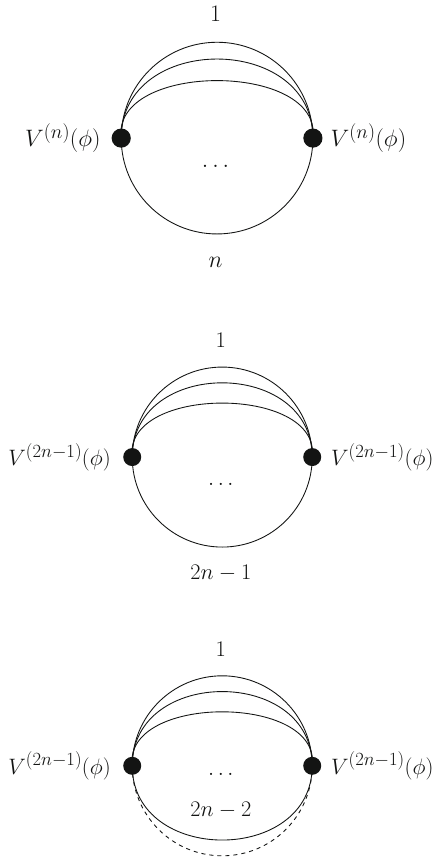
Fig. 1 Diagrammatic representation of (11) in order of appearance. The first and second diagrams are made of n and 2 n − 1 lines of the leading contribution of the Green function G 0 ( x , x (cid:4) ) . Trivially their symmetry factors are n ! and ( 2 n − 1 ) ! respectively. The third diagram is again made of 2 n − 1 lines, but one corresponds to the subleading G 1 ( x , x (cid:4) ) line which is depicted as dashed. Its symmetry factor is ( 2 n − 2 ) ! because there are ( 2 n − 1 ) ways to choose the last